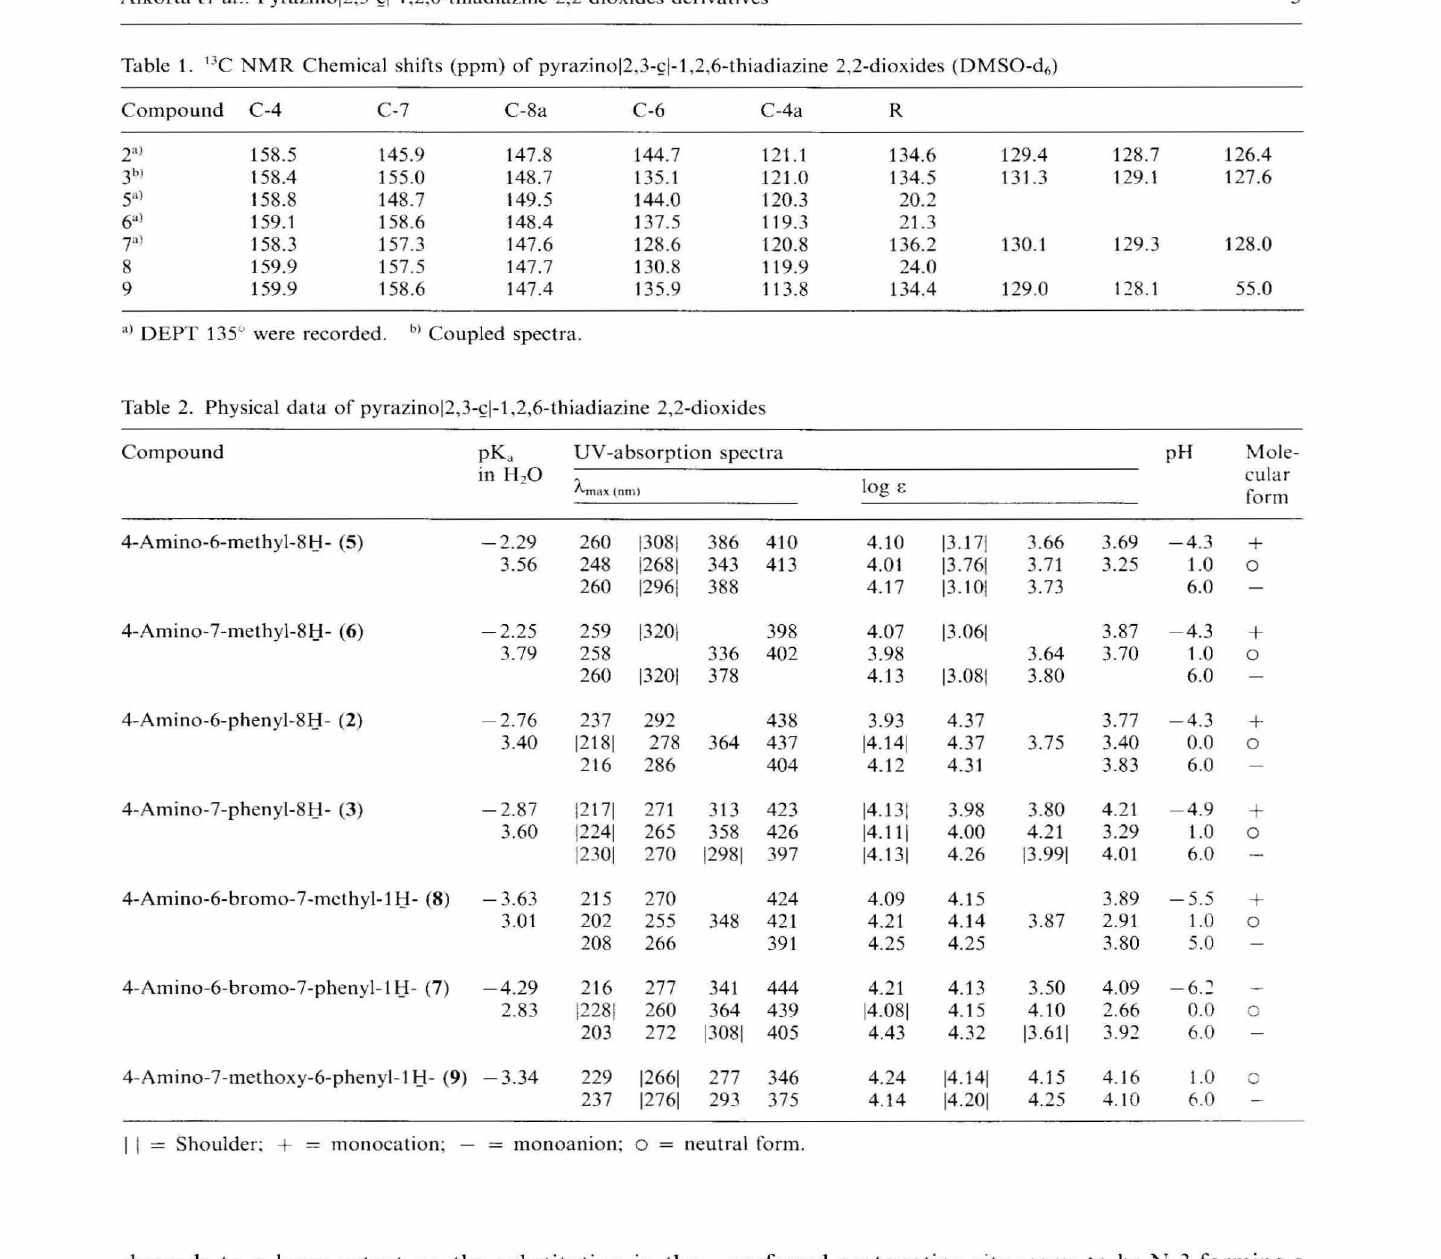
Table 1. 13C NMR Chemical shifts (ppm) of pyrazinoI2,3-~I-l ,2,6-thiadiazine 2,2-dioxides (DMSO-d 6) Compound